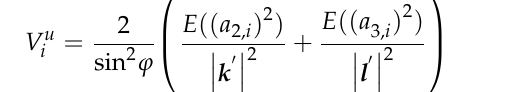
Figure 6. Variation of 2D RMSPE ∆ p with different anchor distances (cid:12) (cid:12) with (cid:12) k (cid:48) (cid:12) provided that